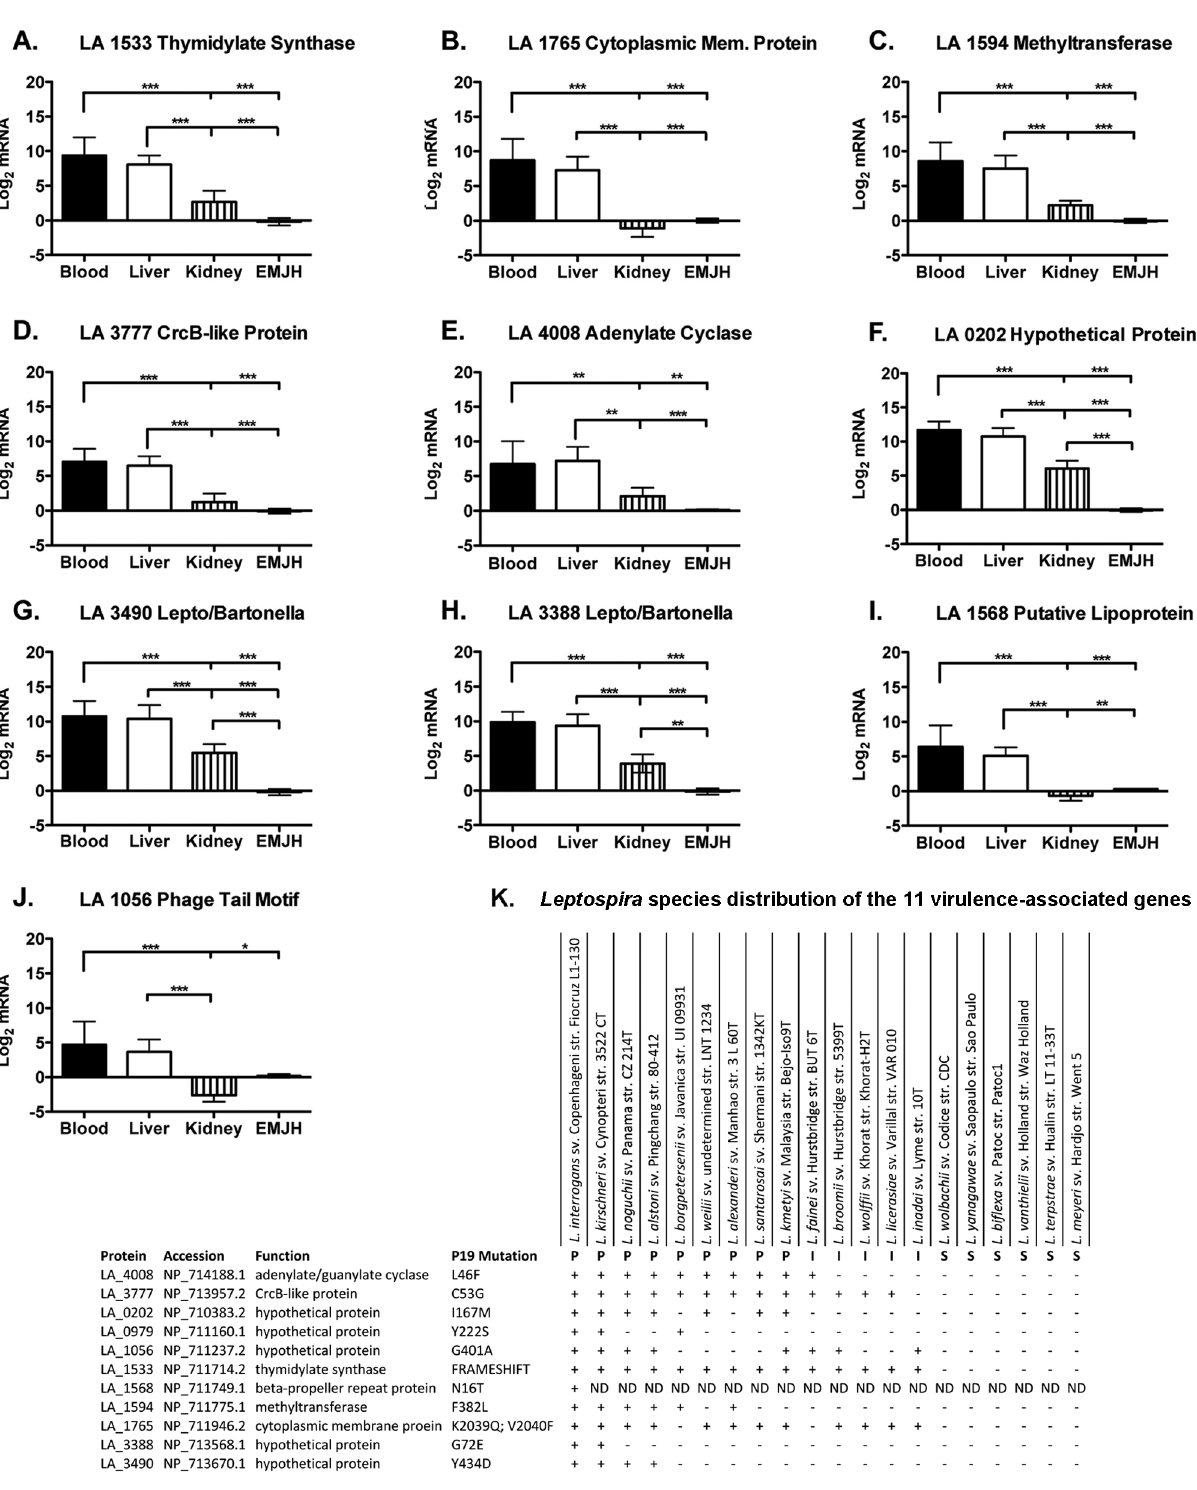
PLOS Neglected Tropical Diseases |